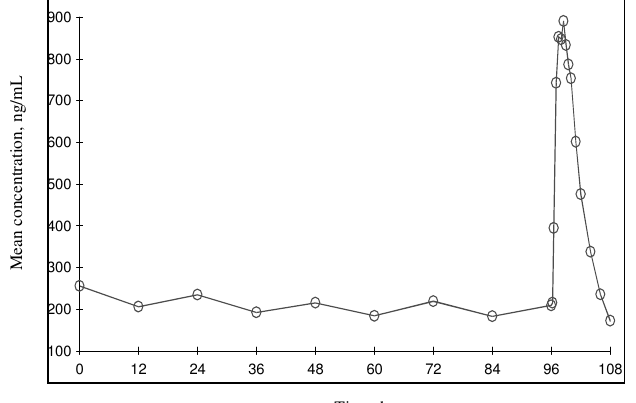
Figure 4. Mean plasma concentration-time profile of QUE in human plasma following oral dosing of QUE tablet (Day-5) to Indian schizophrenia patients under study state